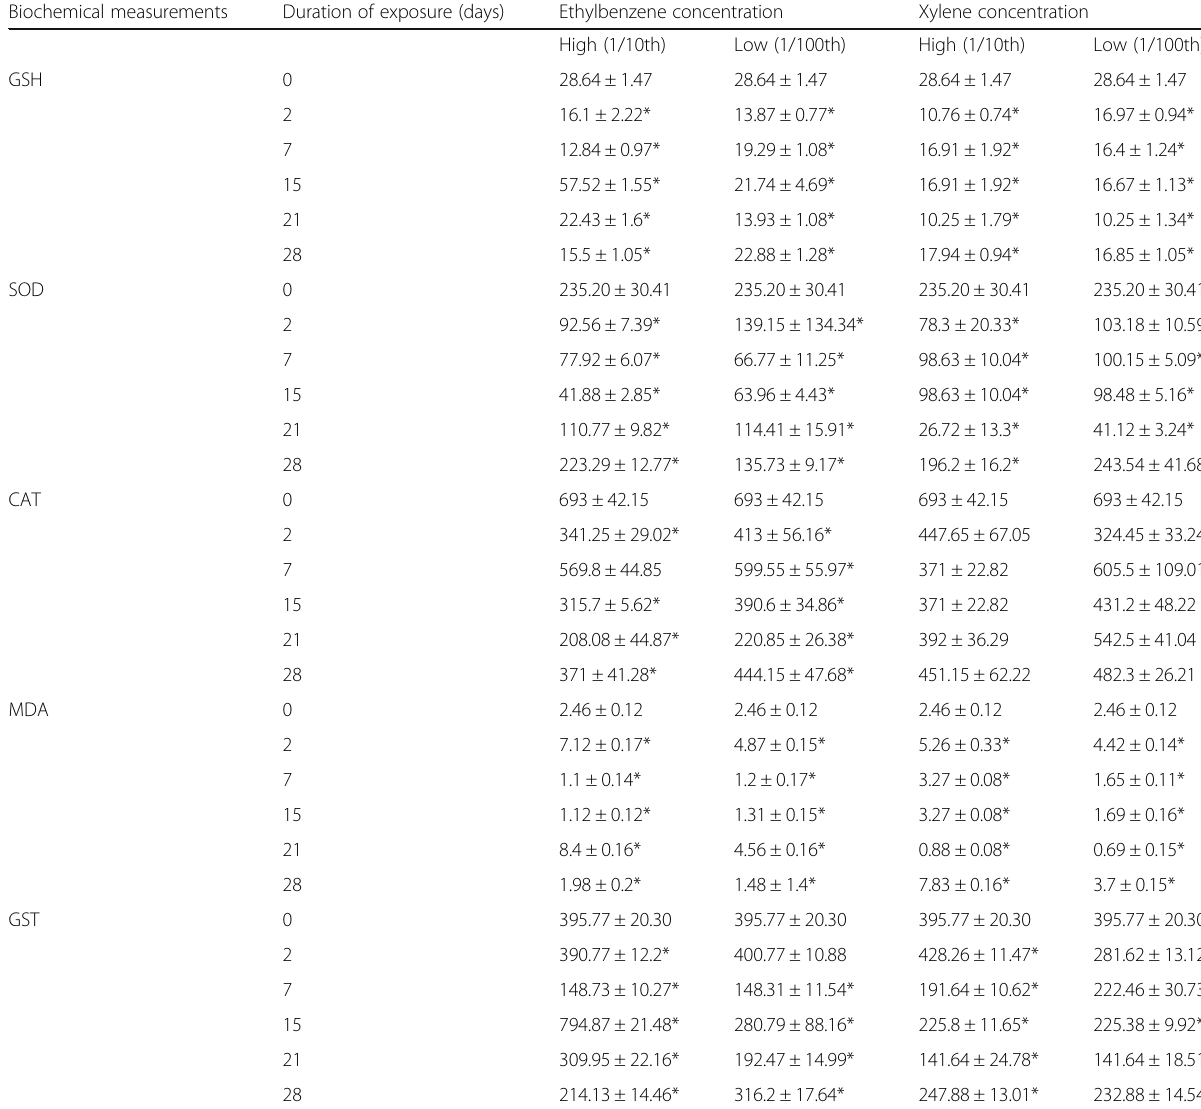
Table 4 Biochemical responses of E. eugeniae exposed to ethyl benzene and xylene contaminated soil Biochemical measurements Duration of exposure